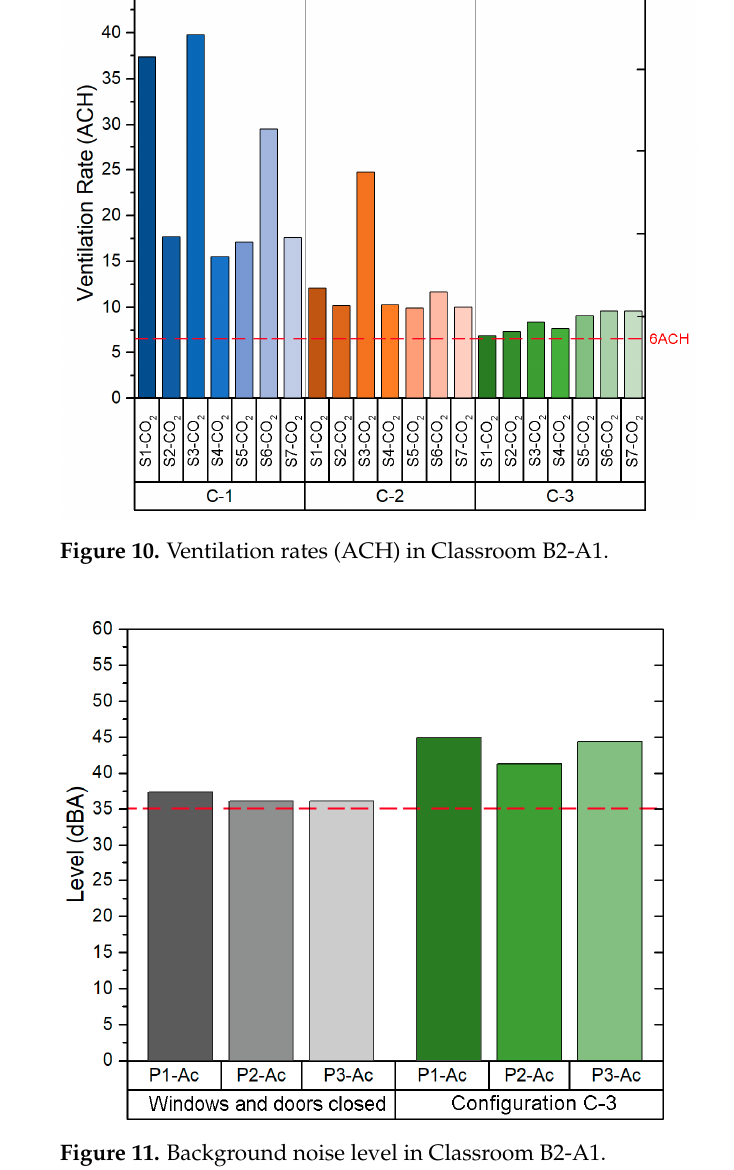
Figure 10. Ventilation rates (ACH) in Classroom B2-A1.